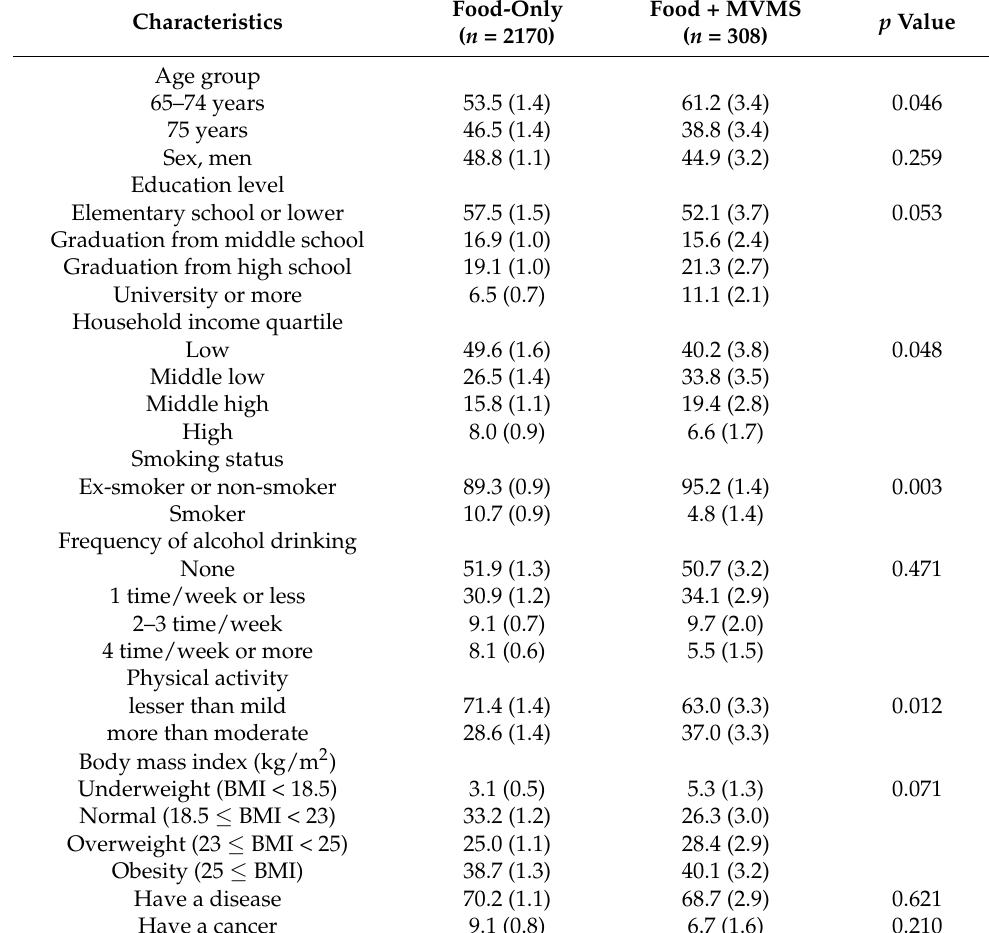
Table 1. Baseline characteristics of participants in the food-only group and food + MVMS group.